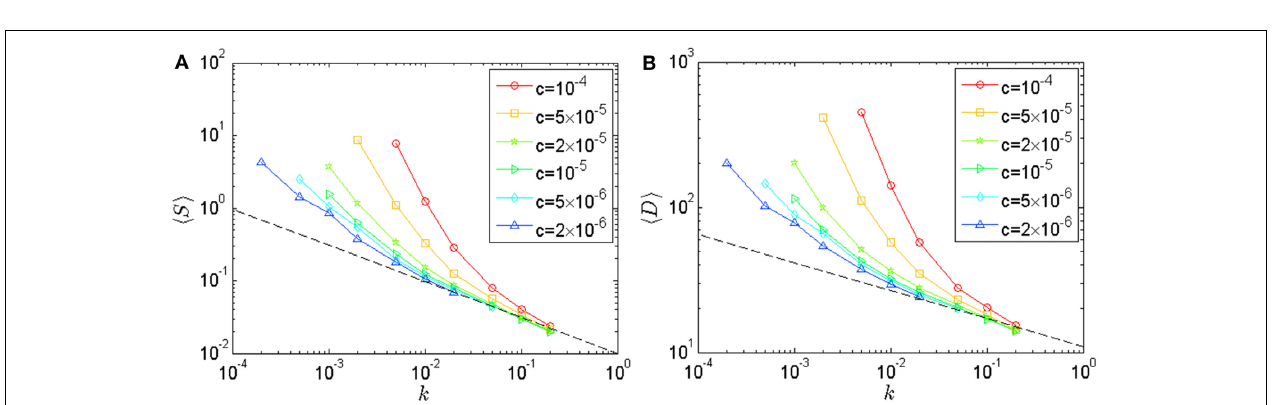
different value of the loading rate c . At large k , the curves collapse onto a c -independent power-law curve. Black thick dash line is a fit over the collapsed region using Equation 11b : (cid:4) D (cid:5) pi ≈ 11 k − (2 − α ) /(cid:17) with α = 1 . 50 and 1 /(cid:17) = 0 . 385. In both (A,B) N = 1024 and ˜ η = 1 and the axes are logarithmic. The different symbols correspond to different values of c , given in the